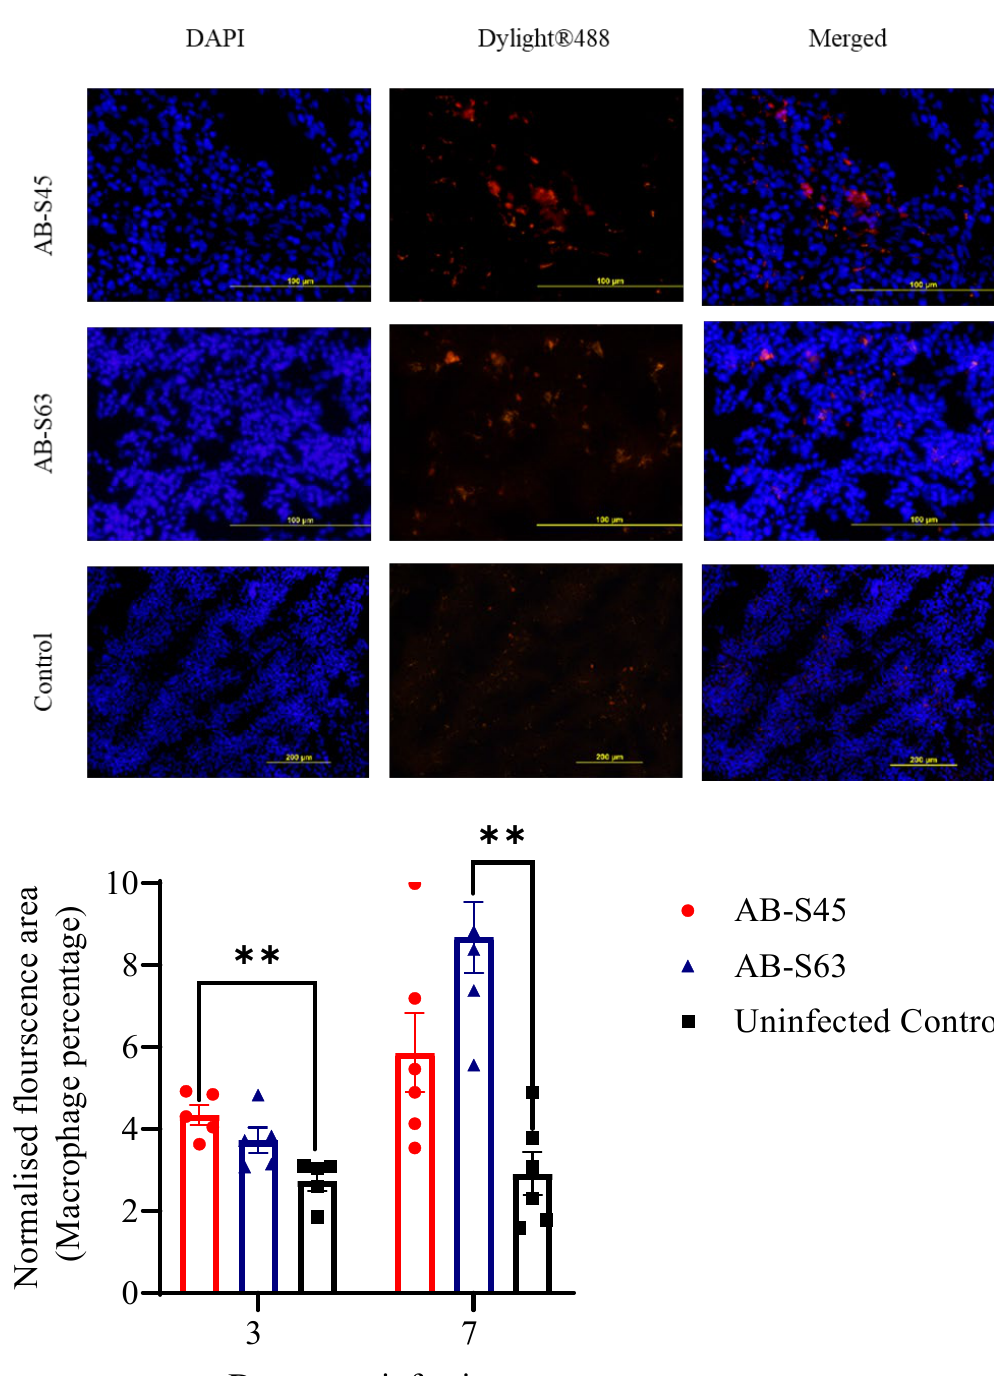
Figure 4. The immune cell recruitment in infected and control lungs following infection with wildtype (AB-S63) and CEO vaccine revertant (AB-S45) ILTV isolates and mock infection with PBS. The representative images show ( a ) CD4+ T cells, ( b ) CD8+ T cells, and ( c ) macrophages present in the lung tissue of the infected and uninfected chickens, along with quantitative data. The Mann–Whitney U test was employed to compare the infected and uninfected groups at 3 and 7 dpi. The error bars indicate the SEM. Significance: * p < 0.05, ** p < 0.01.